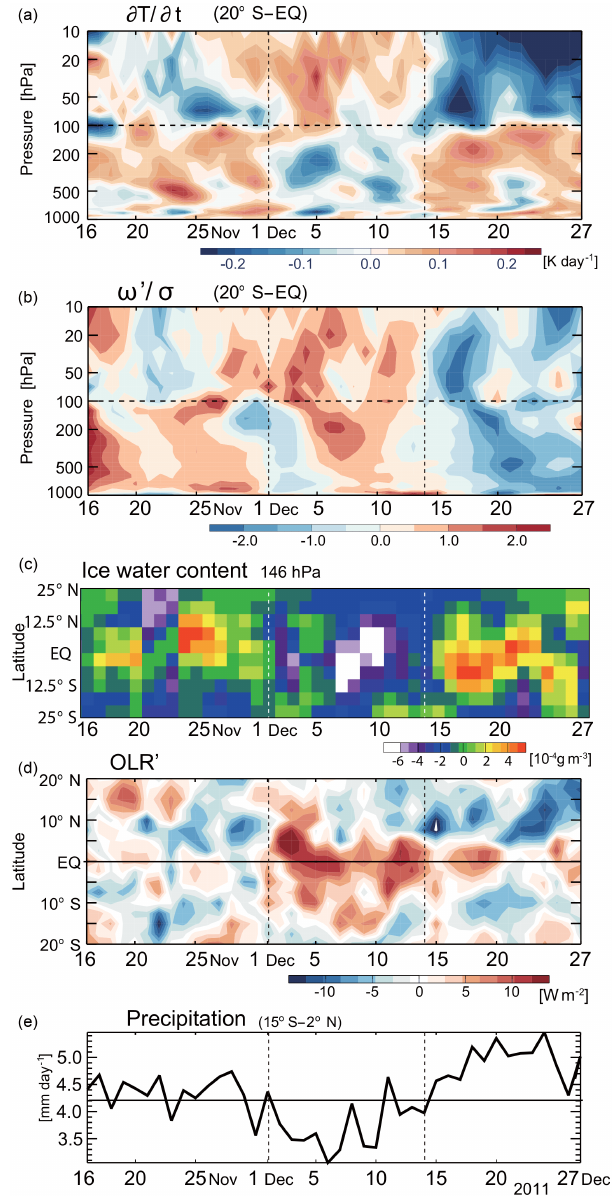
Figure 6. (a) Height–time section of zonal-mean temperature ten- dency averaged from 20 ◦ S to the Equator. (b) Same as (a) but for a 3-day running mean of the anomalous vertical pressure velocity normalized by the daily standard deviation. (c) Latitude–time sec- tion of ice water content at 146hPa, of which linear tendency has been subtracted. (d) Same as (c) but for anomalous OLR. (e) Sur- face precipitation averaged from 15 ◦ S to 2 ◦ N, as estimated from